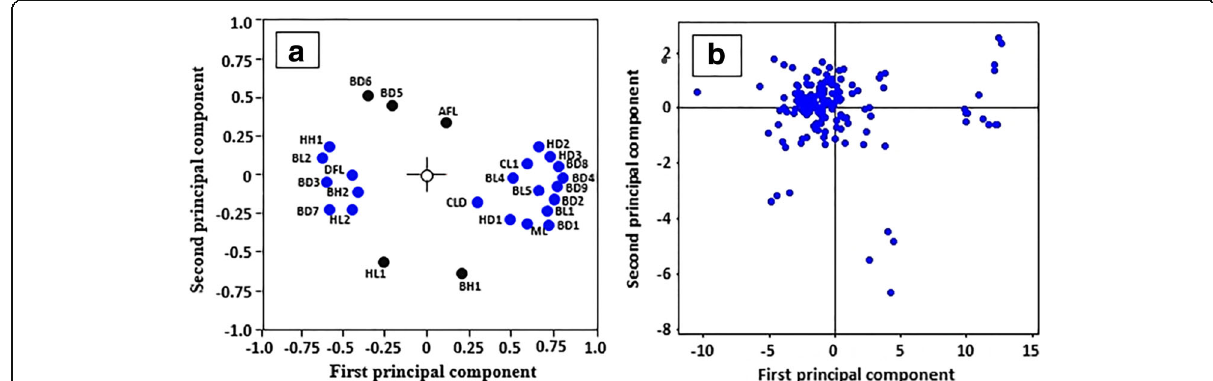
Fig. 4 The principal components analysis on size-corrected truss variables. a The loading plots (PC1, blue dots; PC2, black dots). b The score plots of all individuals